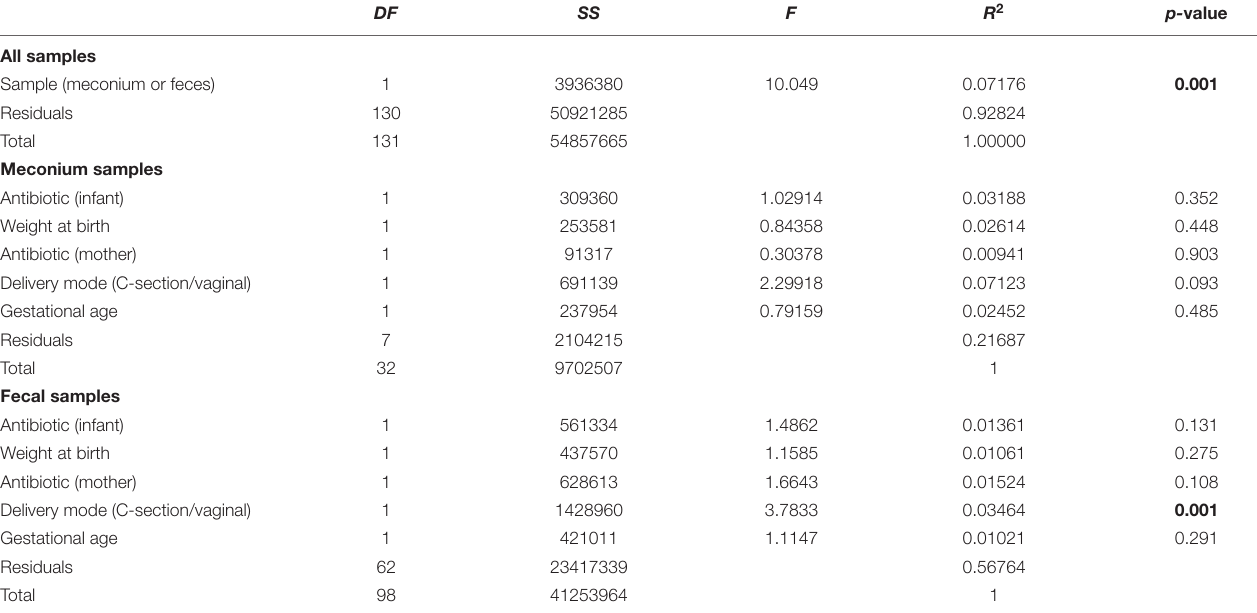
TABLE 3 | Results of perMANOVA analysis of the Euclidean dissimilarities for bacterial OTU community structure used for controlling confounding variables. DF SS F R 2 p-